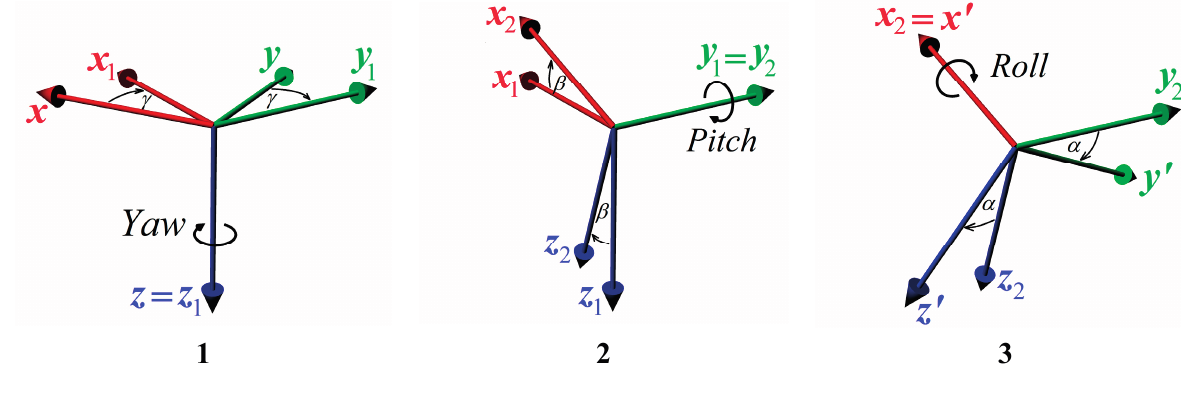
Figure 2. Euler angles for 3-2-1